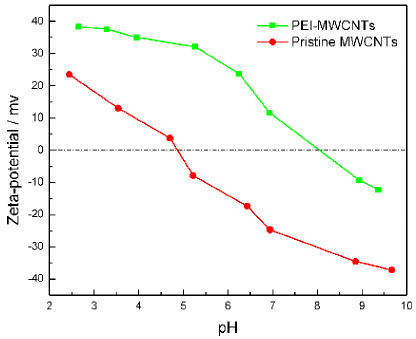
Figure 2. Zeta potential as a function of pH for pristine MWCNTs and PEI ‐ MWCNTs.